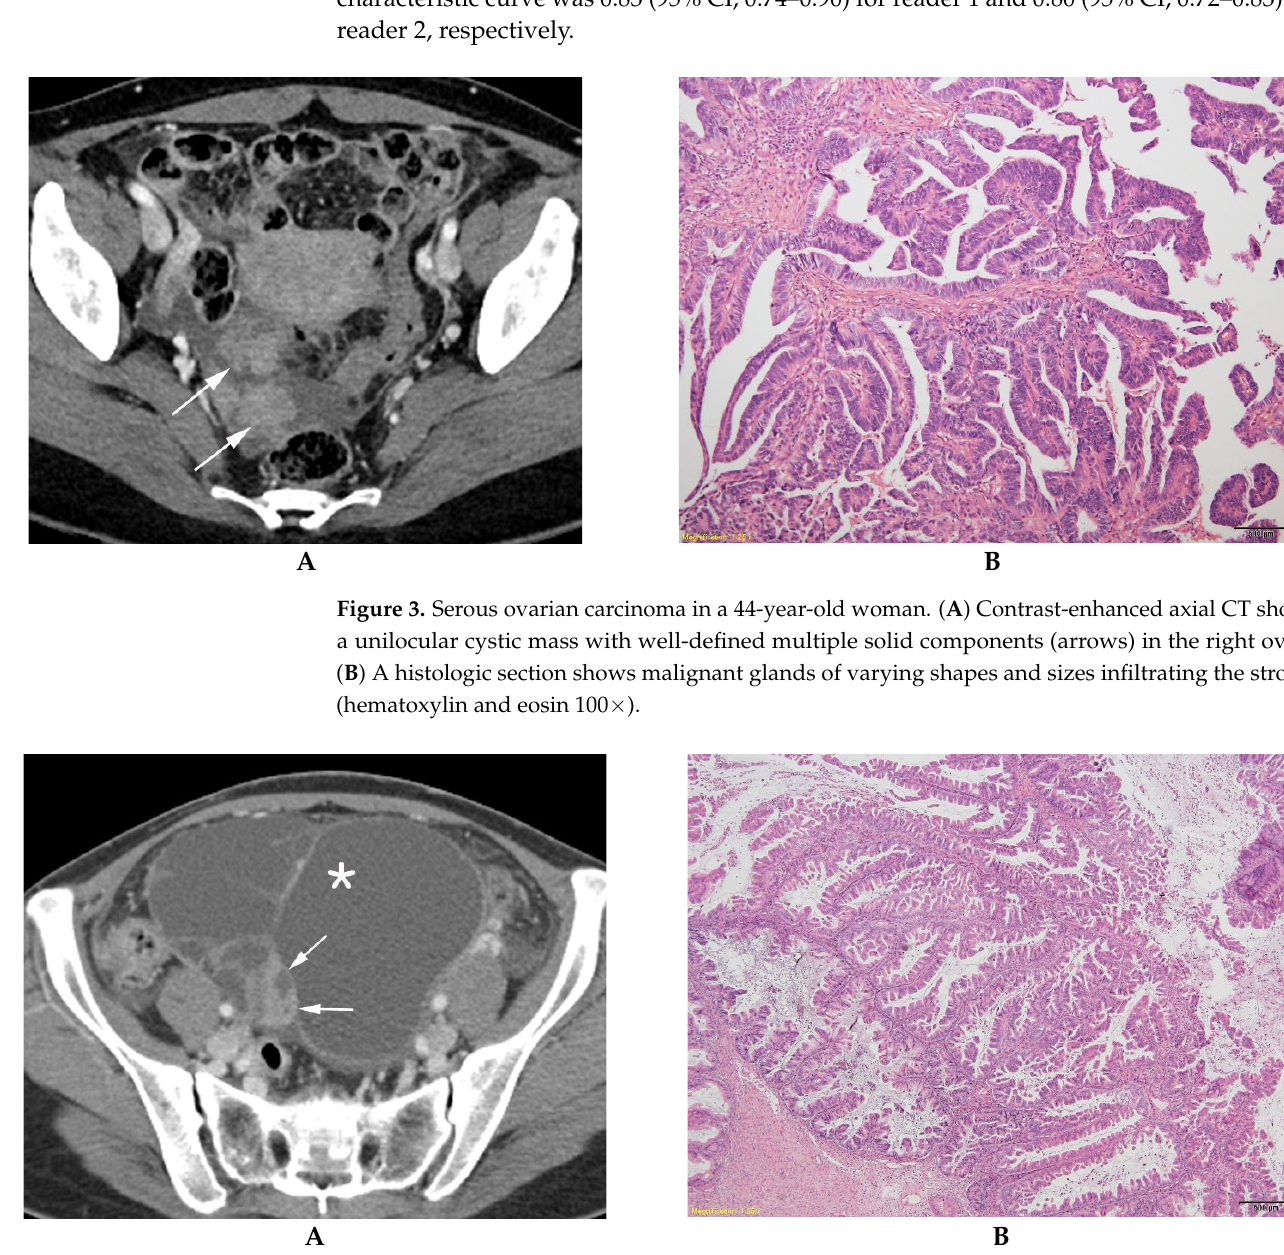
Figure 4. Mucinous ovarian carcinoma in a 31 ‐ year ‐ old woman. ( A ) Contrast ‐ enhanced axial CT shows a multilocular cystic mass (*) with a well ‐ defined solid component (arrows) in the right ovary. ( B ) A histologic section shows malignant back ‐ to ‐ back glands with intracytoplasmic mucin droplets and stromal invasion (hematoxylin and eosin 40×).